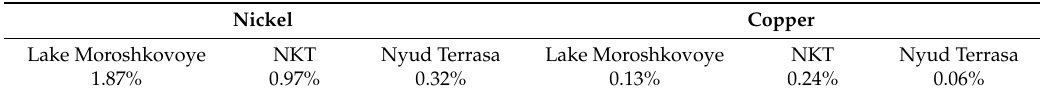
Table 2. Leaching intensities of non-ferrous metals per